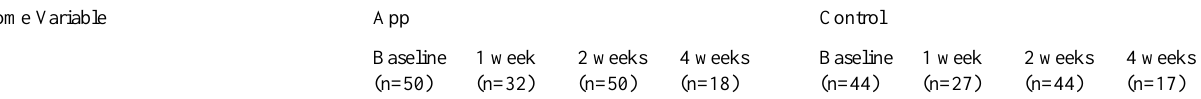
Table 4. Mean (SD), fruit and vegetable knowledge scores, self-reported intake, and drink choice for all volunteers at baseline and at weeks 1, 2, and 4. ControlAppOutcome